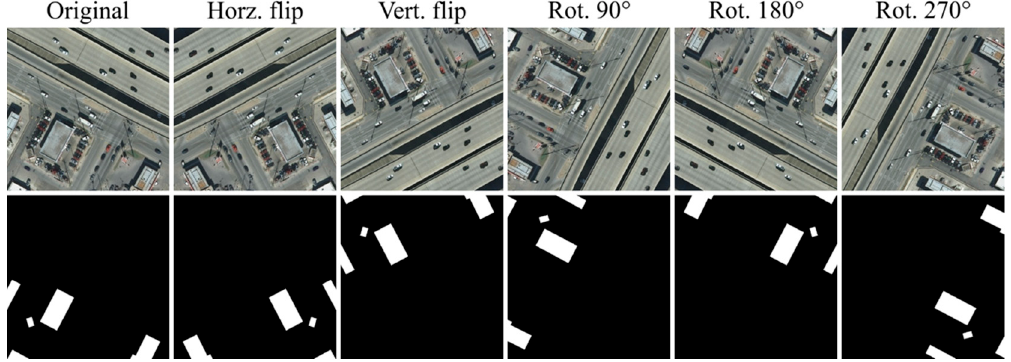
Figure 3. Illustration of data augmentation technique that produces five variations of the original image and ground truth patches.